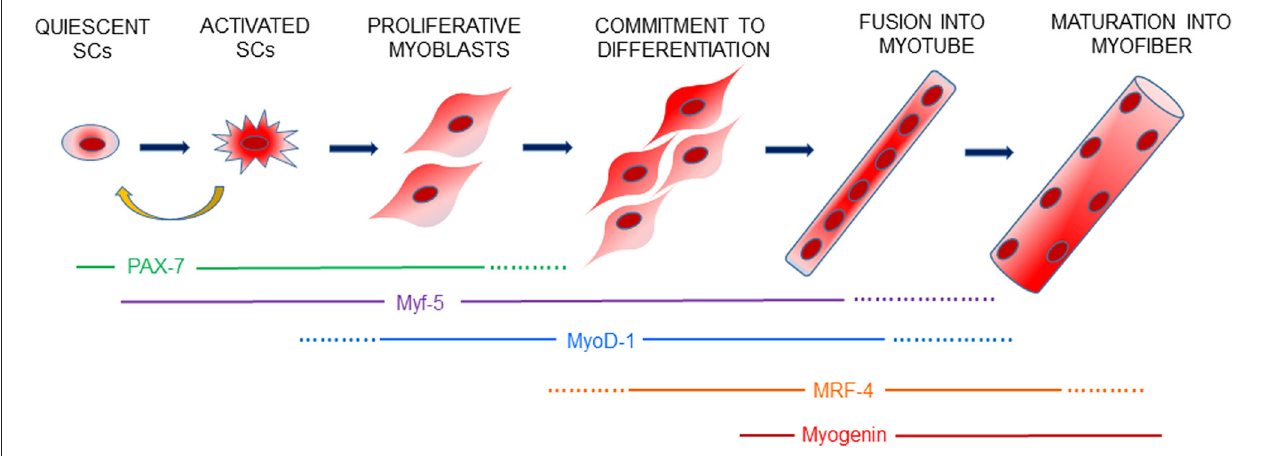
FIGURE 1 | Schematic view of myogenesis. Skeletal muscle regeneration is finely controlled by a genetic cascade involving PAX-7 and the myogenic regulatory factors, Myf-5, MyoD-1, MRF-4 and Myogenin, which drive every step of SCs activation, proliferation of myoblasts and the differentiation and formation of new muscle fibers. Activated SCs can retain PAX-7 expression and return to a quiescent state to contribute to the replenishment of the SCs pool for future muscle